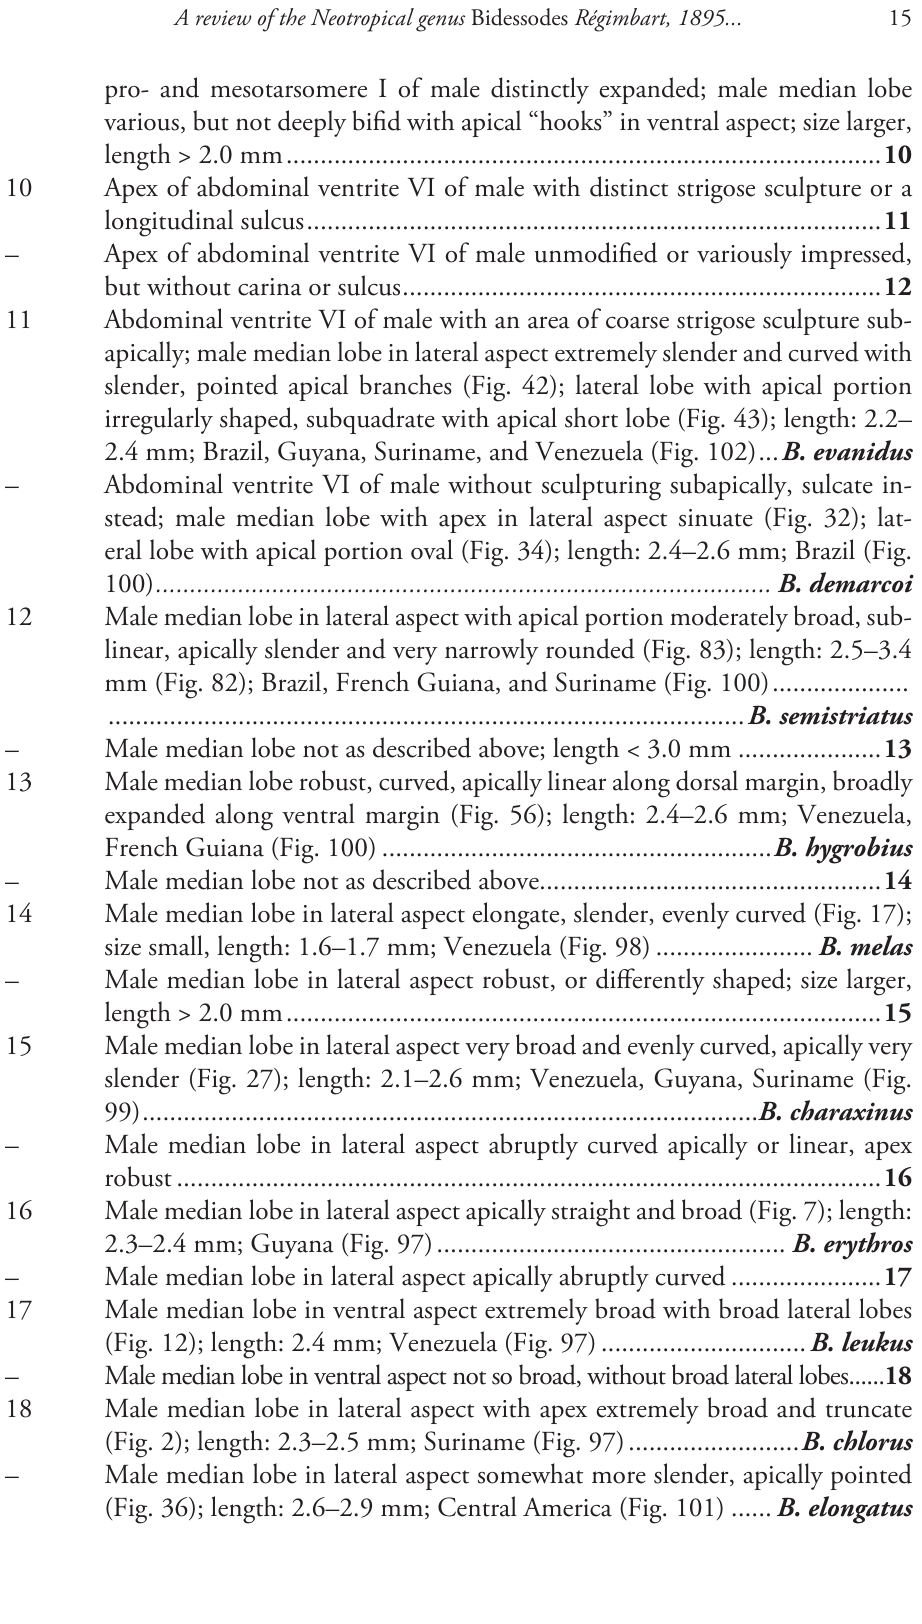
pro- and mesotarsomere I of male distinctly expanded; male median lobe various, but not deeply bifid with apical “hooks” in ventral aspect; size larger, length > 2.0 mm ....................................................................................... 10 10 Apex of abdominal ventrite VI of male with distinct strigose sculpture or a longitudinal sulcus .................................................................................... 11 – Apex of abdominal ventrite VI of male unmodified or variously impressed, but without carina or sulcus ...................................................................... 12 11 Abdominal ventrite VI of male with an area of coarse strigose sculpture sub- apically; male median lobe in lateral aspect extremely slender and curved with slender, pointed apical branches (Fig. 42); lateral lobe with apical portion irregularly shaped, subquadrate with apical short lobe (Fig. 43); length: 2.2– 2.4 mm; Brazil, Guyana, Suriname, and Venezuela (Fig. 102) ... B. evanidus – Abdominal ventrite VI of male without sculpturing subapically, sulcate in- stead; male median lobe with apex in lateral aspect sinuate (Fig. 32); lat- eral lobe with apical portion oval (Fig. 34); length: 2.4–2.6 mm; Brazil (Fig. 100) .......................................................................................... B. demarcoi 12 Male median lobe in lateral aspect with apical portion moderately broad, sub- linear, apically slender and very narrowly rounded (Fig. 83); length: 2.5–3.4 mm (Fig. 82); Brazil, French Guiana, and Suriname (Fig. 100) .................... ............................................................................................. B. semistriatus – Male median lobe not as described above; length < 3.0 mm ..................... 13 13 Male median lobe robust, curved, apically linear along dorsal margin, broadly expanded along ventral margin (Fig. 56); length: 2.4–2.6 mm; Venezuela, French Guiana (Fig. 100) ......................................................... B. hygrobius – Male median lobe not as described above .................................................. 14 14 Male median lobe in lateral aspect elongate, slender, evenly curved (Fig. 17); size small, length: 1.6–1.7 mm; Venezuela (Fig. 98) ....................... B. melas – Male median lobe in lateral aspect robust, or differently shaped; size larger, length > 2.0 mm ....................................................................................... 15 15 Male median lobe in lateral aspect very broad and evenly curved, apically very slender (Fig. 27); length: 2.1–2.6 mm; Venezuela, Guyana, Suriname (Fig. 99) .......................................................................................... B. charaxinus – Male median lobe in lateral aspect abruptly curved apically or linear, apex robust ....................................................................................................... 16 16 Male median lobe in lateral aspect apically straight and broad (Fig. 7); length: 2.3–2.4 mm; Guyana (Fig. 97) ................................................... B. erythros – Male median lobe in lateral aspect apically abruptly curved ...................... 17 17 Male median lobe in ventral aspect extremely broad with broad lateral lobes (Fig. 12); length: 2.4 mm; Venezuela (Fig. 97) .............................. B. leukus – Male median lobe in ventral aspect not so broad, without broad lateral lobes ...... 18 18 Male median lobe in lateral aspect with apex extremely broad and truncate (Fig. 2); length: 2.3–2.5 mm; Suriname (Fig. 97) ......................... B. chlorus – Male median lobe in lateral aspect somewhat more slender, apically pointed (Fig. 36); length: 2.6–2.9 mm; Central America (Fig. 101) ...... B.